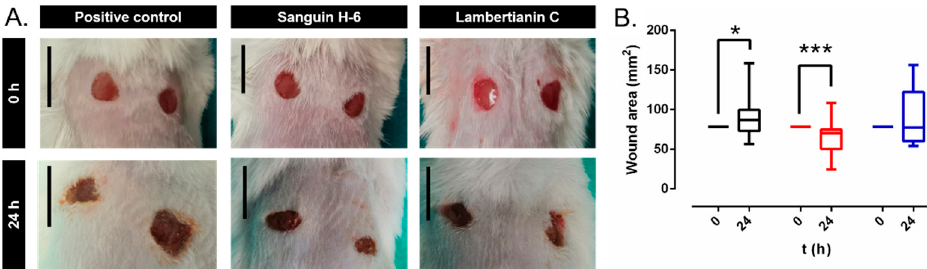
between wounds of the same mouse is a result of each animal tending to focus on and compulsively scratch one wound more than another. ( B ) The wound area measurements in each experimental group: positive control (black), sanguiin H-6 (red), and lambertianin C (blue). *: p- value < 0.05, ***: p- value < 0.001 for paired Wilcoxon test.